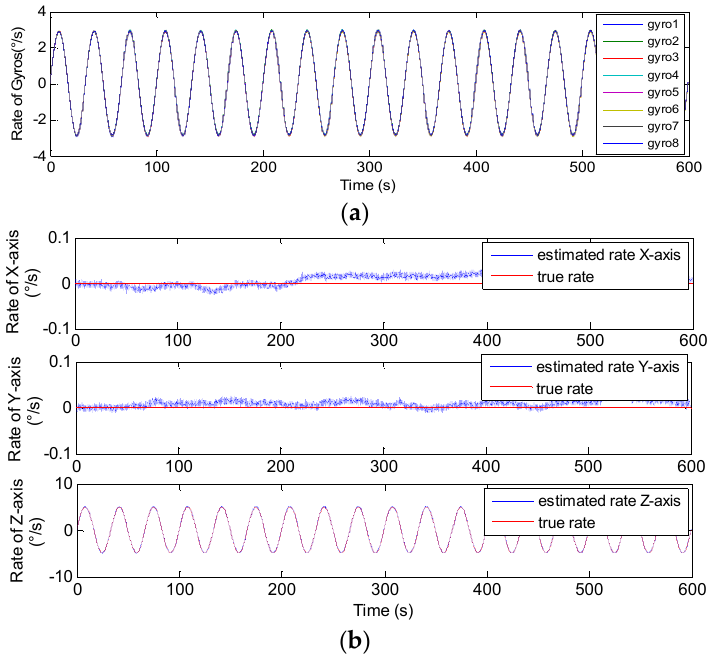
Figure 17. Sinusoidal results of the 8-gyro MIMU system for scheme 1. ( a ) The outputs of the gyros. ( b ) The estimated results of the MIMU.